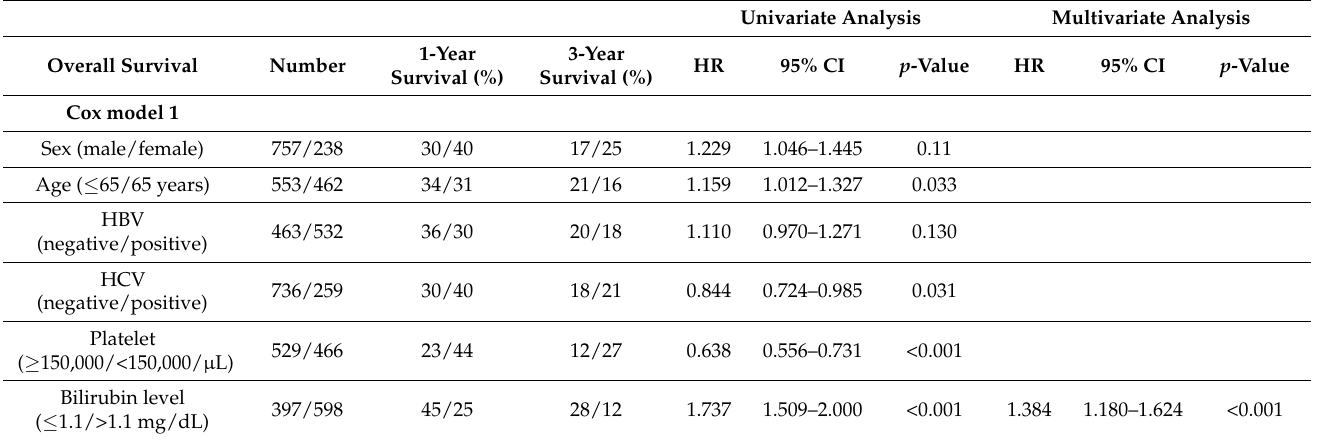
Table 3. Univariate and multivariate survival analyses of HCC patients with ascites ( n =